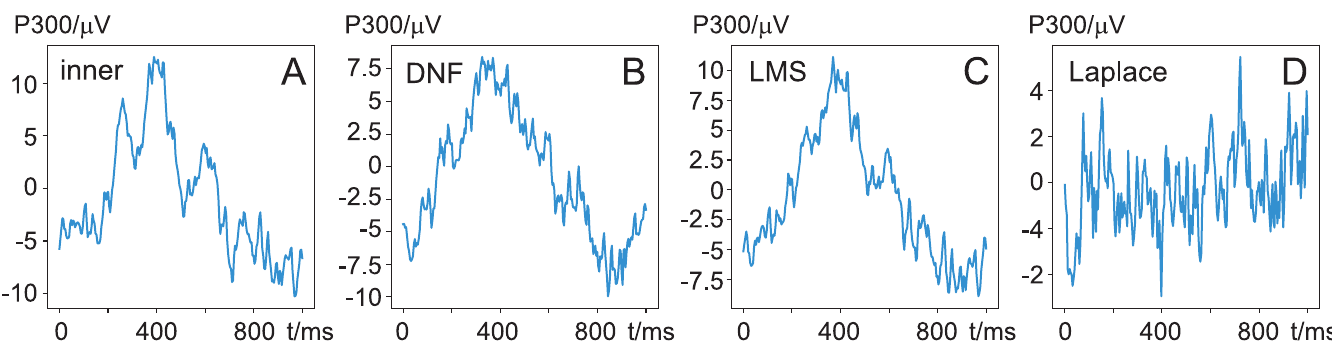
Fig 3. P300 averages from subject 10. While looking at a chequerboard that inverted every second, the subject was presented with oddball stimuli every 7sec-13sec with a random pattern. The recording was 5 minutes long. A: the event-triggered average from the inner electrode d [ n ], B: the event-triggered average from the output e [ n ] of the DNF, C: the output from the LMS filter (adaptive FIR filter) and D: from the Laplace filter: ~ d ½ n � (cid:0) ~ x ½ n � with DC and 50 Hz removed after the subtraction operation.